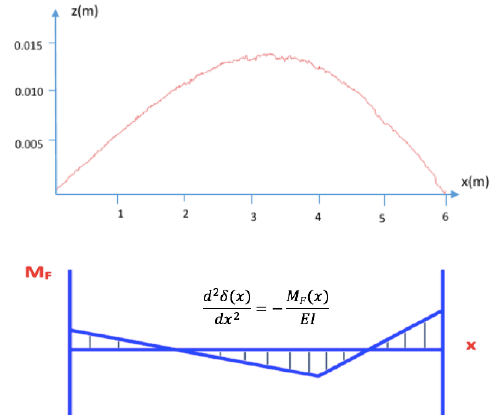
Figure 5. Height images at the centroid (top) and derived bending moment diagram (bottom) for obtained from a certain load.